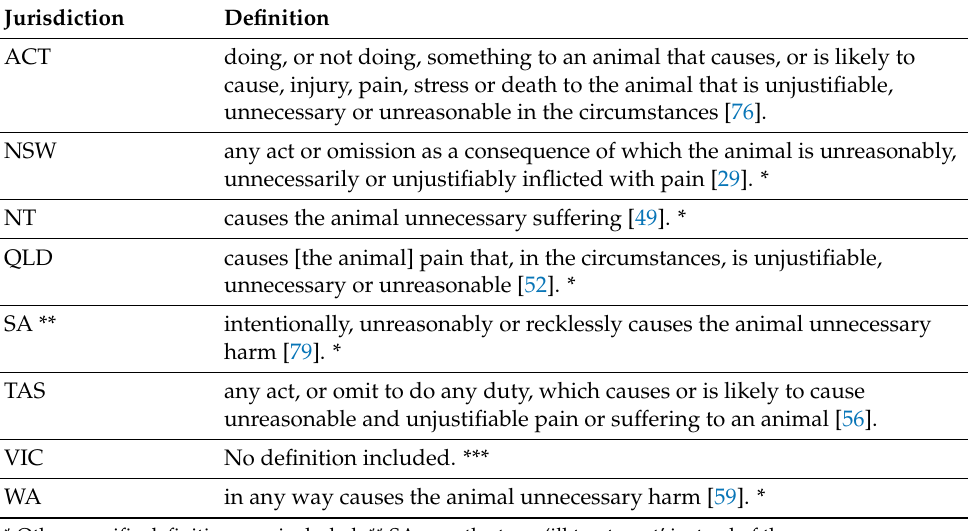
Table 7. Definition of cruelty in the corresponding state and territory animal welfare